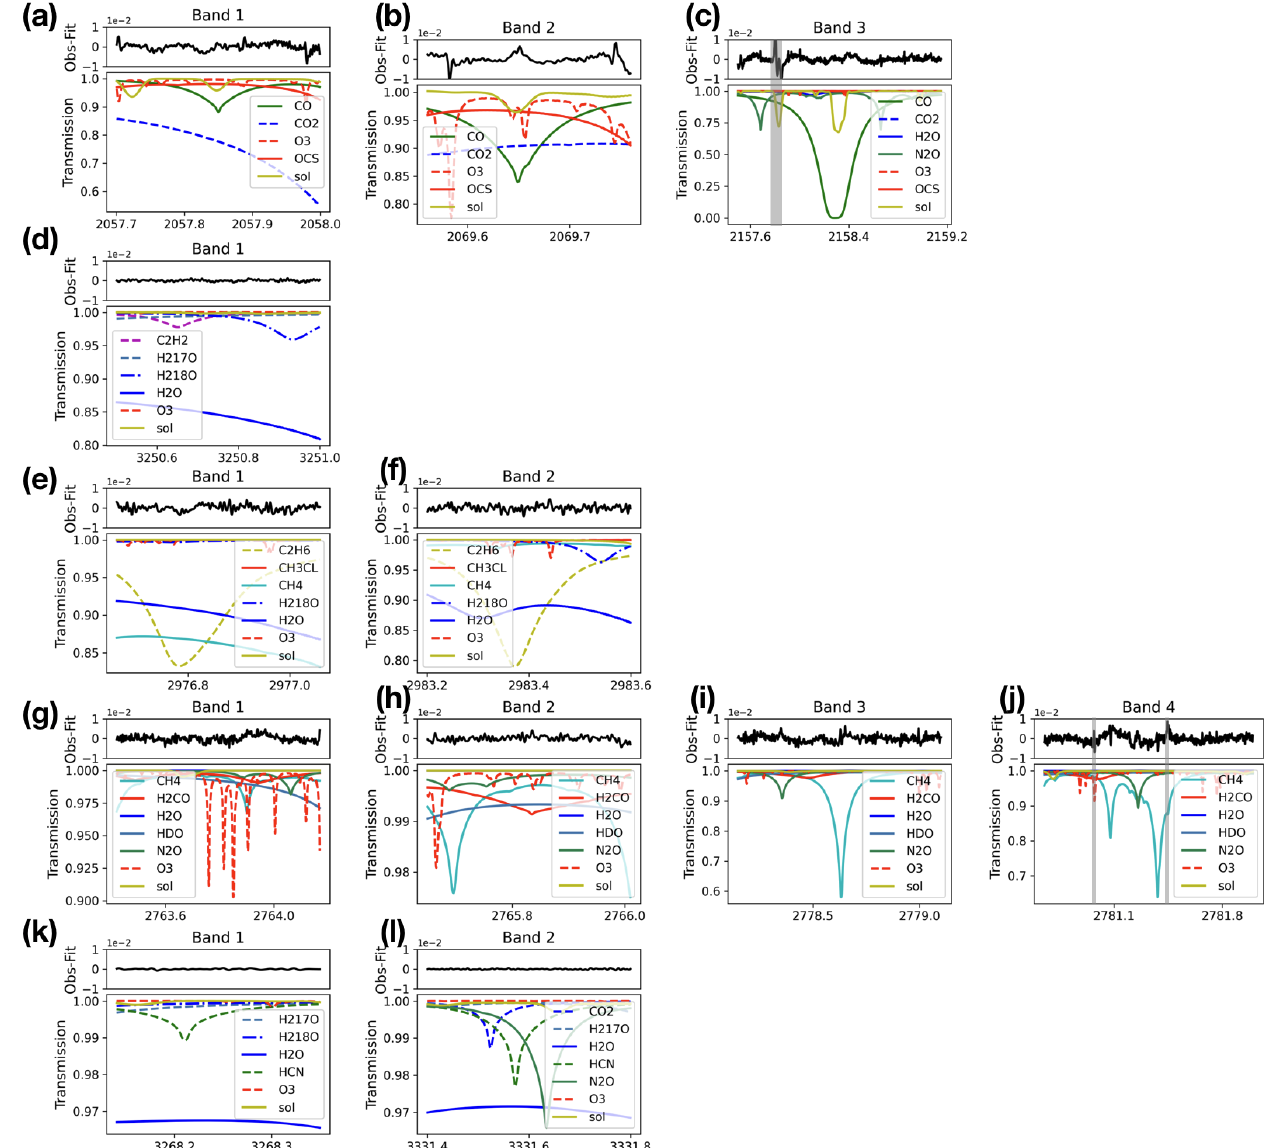
Figure 3. The retrieval windows for CO (a, b, c) , C 2 H 2 (d) , C 2 H 6 (e, f) , H 2 CO (g, h, i, j) and HCN (k, l) . For each window, the bottom panel is the normalized transmittance from atmospheric species and the solar line, which the upper panel is the residual between the fitted and observed spectra. Note that there is one de-weighting window (2157.775–2157.905cm − 1 ) in CO band 3 and two de-weighting